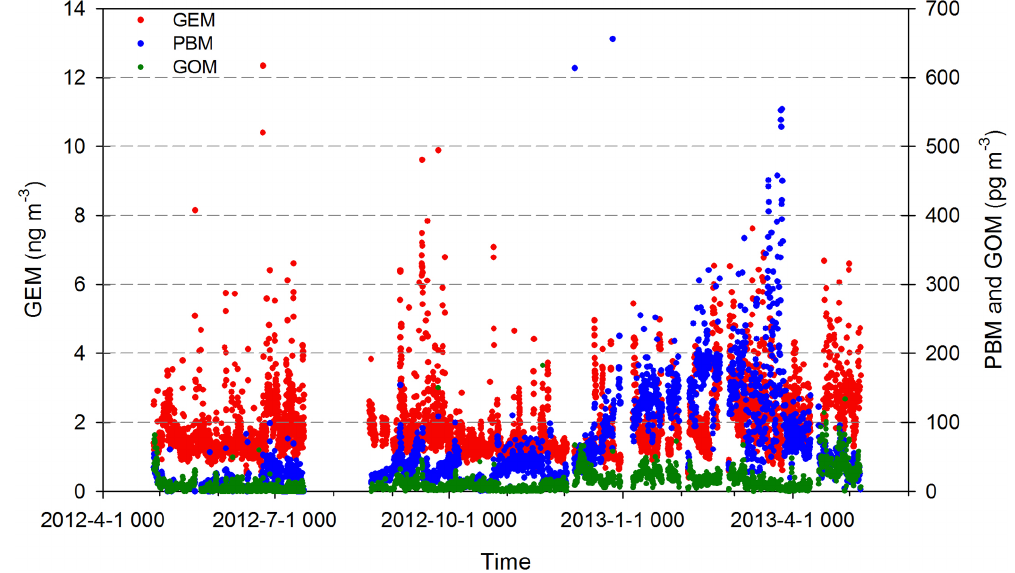
Figure 2. Time series of hourly GEM, GOM and PBM concentrations in ambient air at